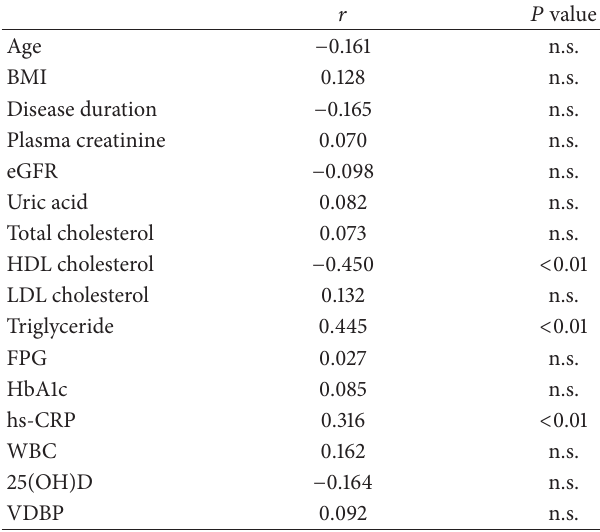
Plasma LL-37 level was 71.2 ± 22.3 ng/mL (mean ±